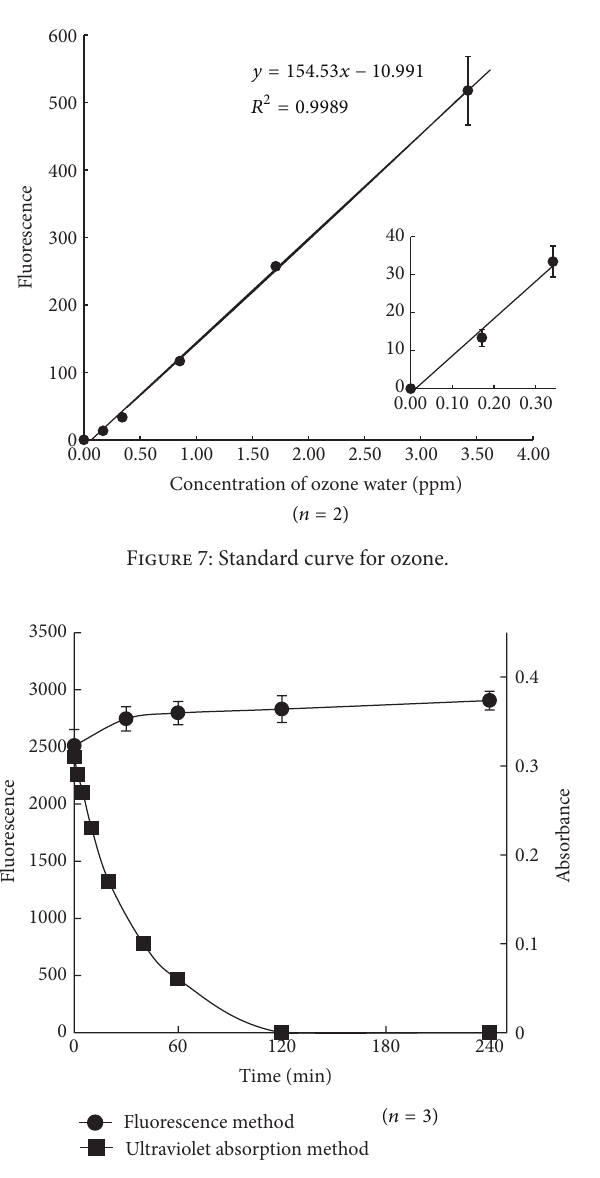
Figure 8: Stability of the reaction product from Probe 1 reacted with ozone (fluorescence method) and absorbance of ozone water (ultraviolet absorption